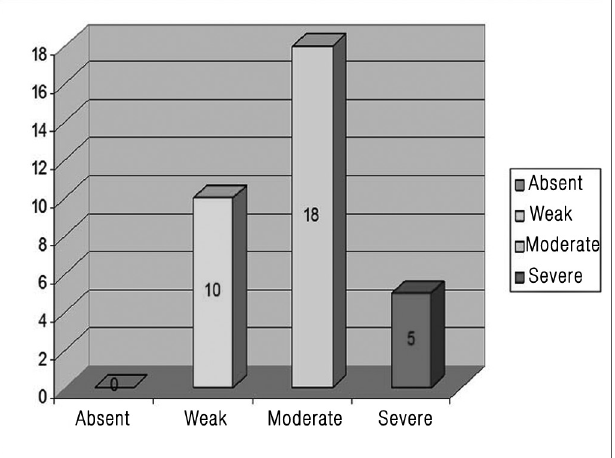
Figure 5. ITNR-R2 distribution in the cholesteatoma fragments